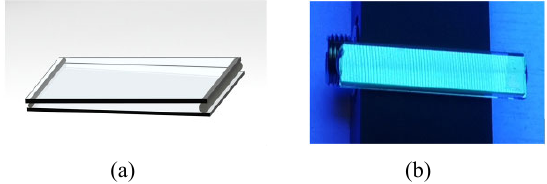
Fig. 5 Figure of the optical wedge: (a) diagram of the optical wedge and (b) the physical picture of the optical wedge.